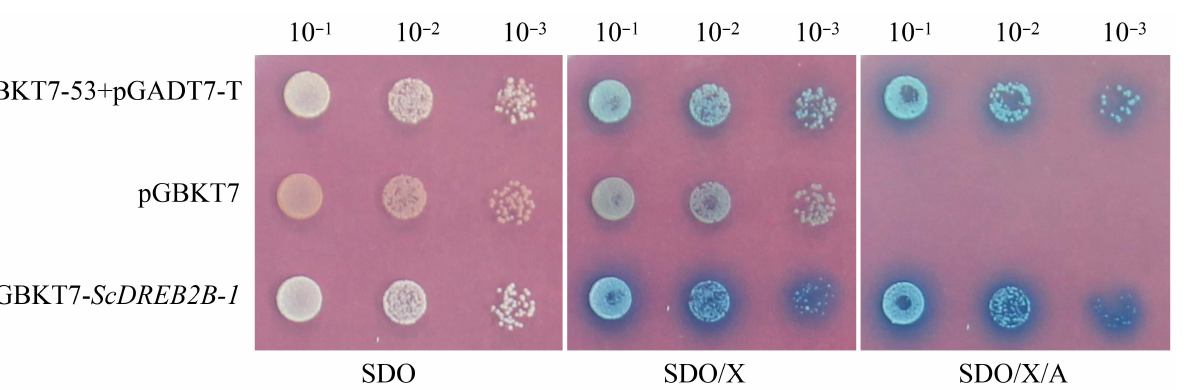
Figure 5. The transcriptional self-activation activity of ScDREB2B-1 protein in yeast. SDO: media without tryptophan; SDO/X: media without tryptophan but containing Trp/X- α -Gal dye; SDO/X/A: